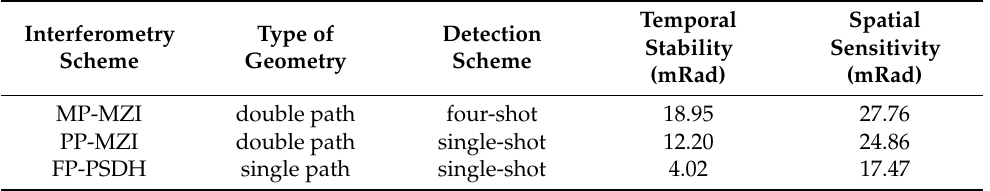
Figure 5. Experimental results: Butterfly wing; ( a ) raw intensity distribution of single-shot recorded hologram; ( b ) reconstructed amplitude distribution; ( c ) reconstructed phase distribution. USAF negative (reflective) target; ( d ) raw intensity distribution of single-shot recorded hologram; ( e ) reconstructed amplitude distribution; ( f ) reconstructed phase distribution. A 4f-imaging system with lenses of focal length 100 mm and 200 mm is utilized to image the object plane to the sensor plane. Scale bar: ( a – c ) 300 μm, ( d – f ) 100 μm. Table 1. Quantitative comparison of FP-PSDH system performance with MP-MZI and PP- MZI